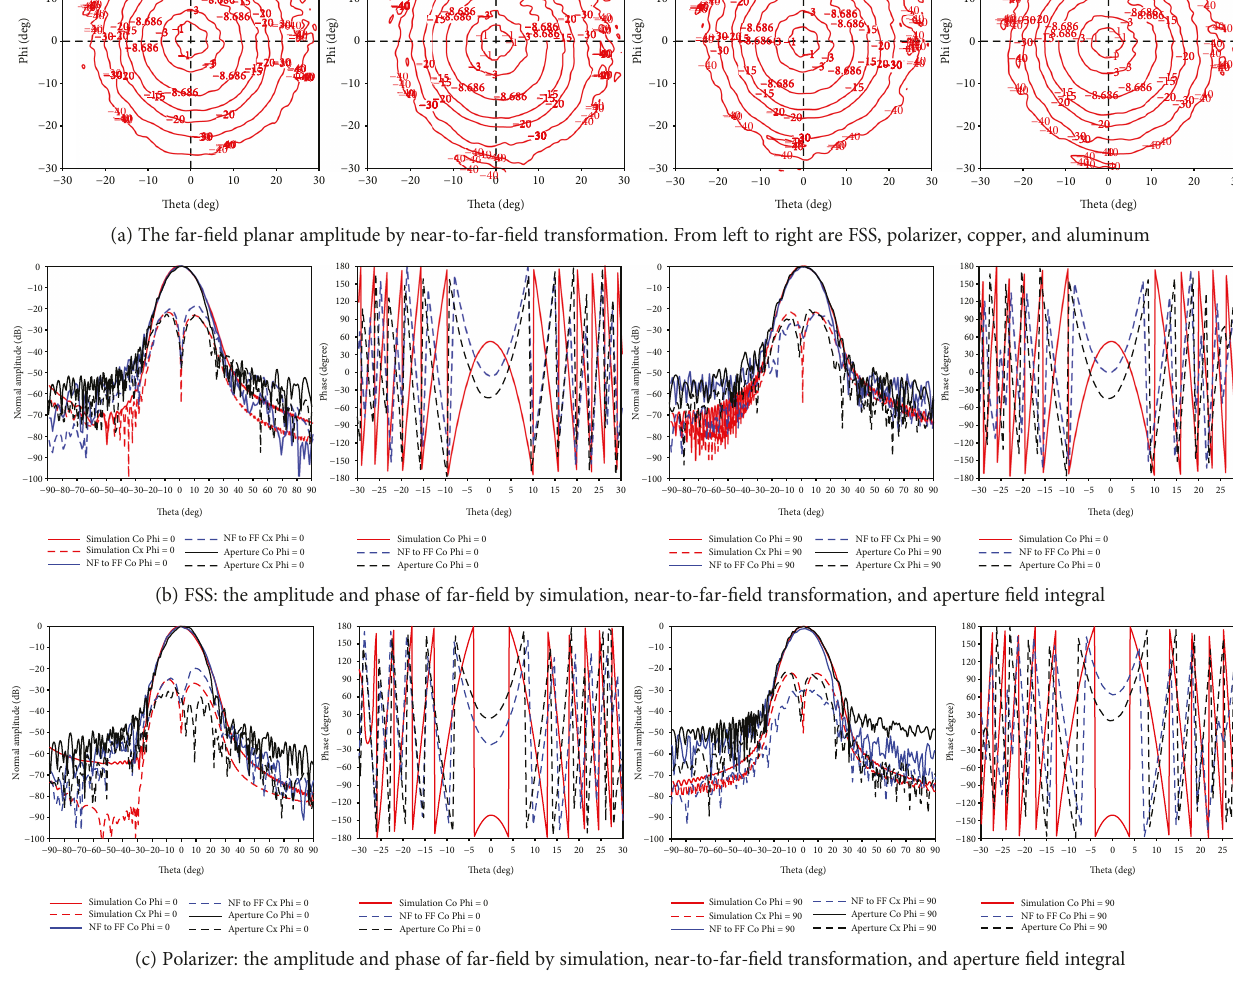
Figure 12: The far- fi eld radiation pattern results of 183GHz channel. Table 3: The far- fi eld results of 183GHz